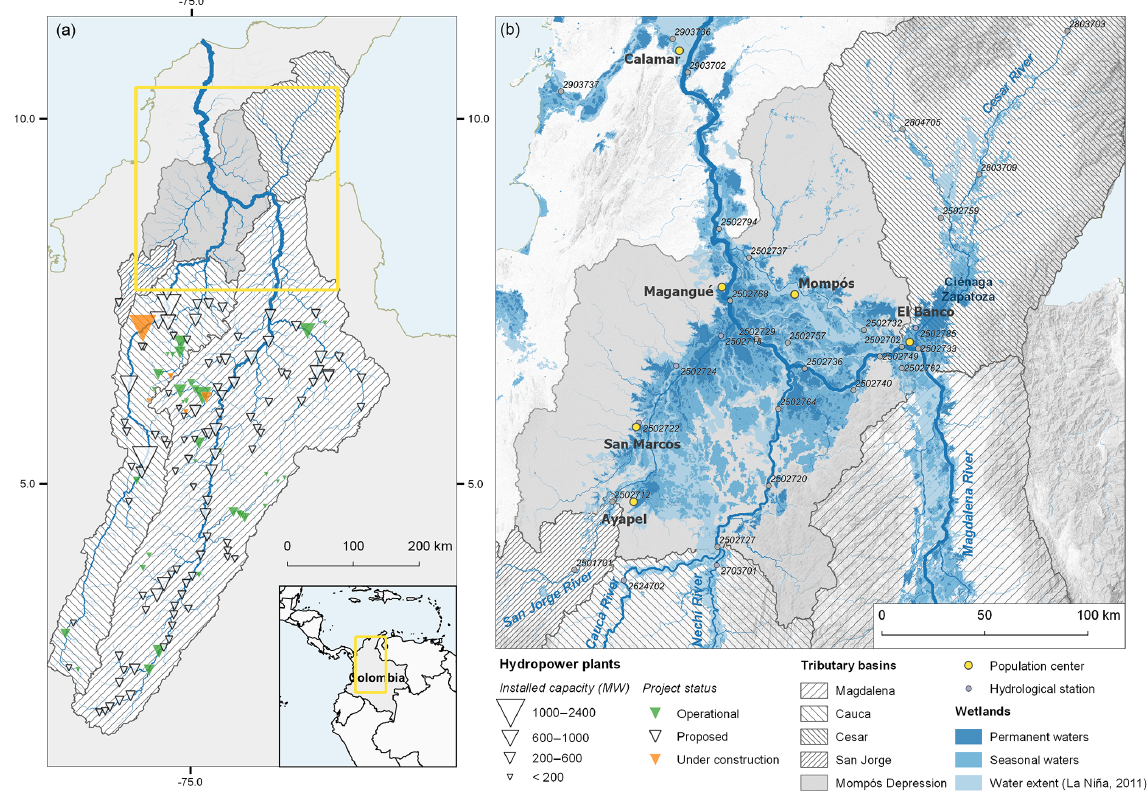
Figure 1. Map of the Magdalena River basin showing existing and proposed hydropower dams (a) , and the Mompós Depression low flood- plains system and hydrological stations (numbered) referenced in the text (b)